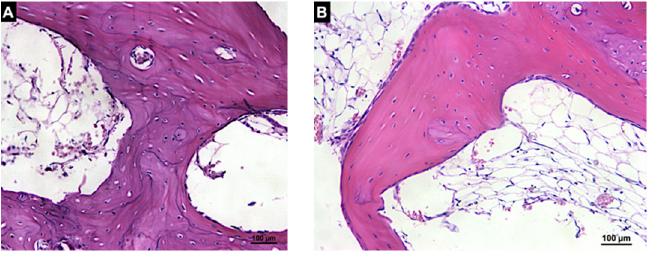
Figure 10. Histologic photomicrography of the Base region in the autogenous ( A ) and xenogenous ( B ) grafts after 60 days of healing. The autografts were well-incorporated into the recipient bed and the xenografts were connected to the cortical bone through sparse bone bridges. Hematoxylin and eosin stain; magnification 200×.